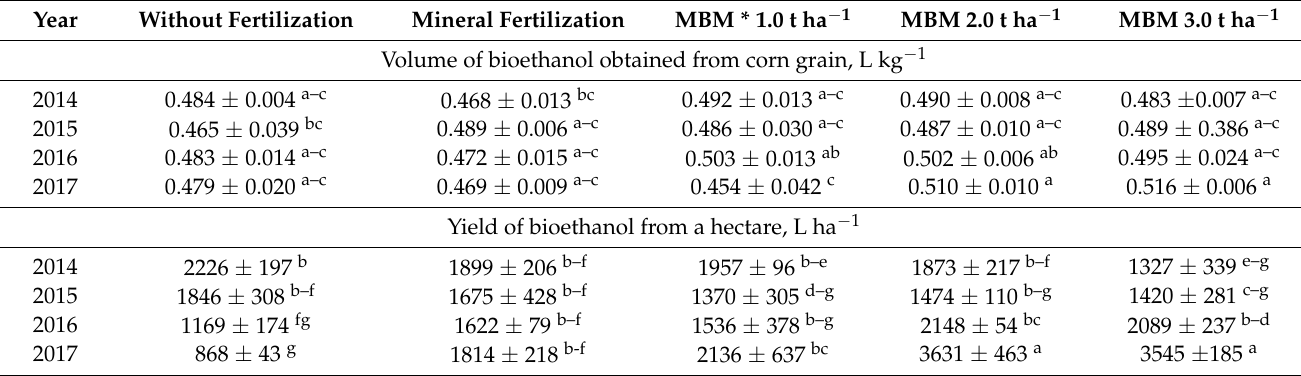
Table 8. Interaction between the years and treatments for volume of bioethanol obtained from corn grain, and yield of bioethanol from a hectare, (mean value and standard deviation).